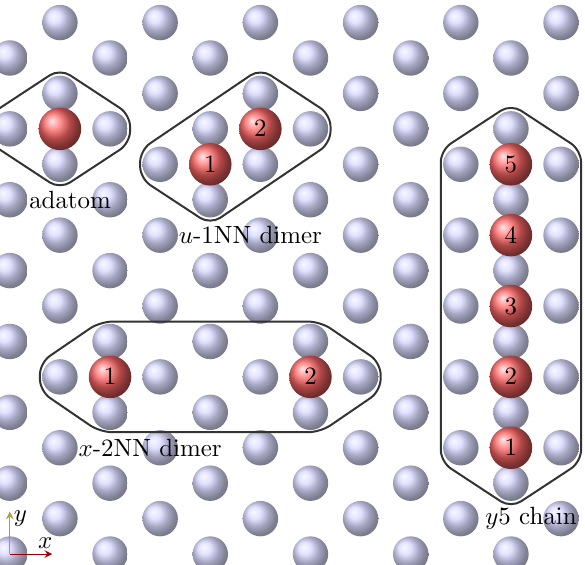
Figure 1. Illustration of the atomic clusters. Red balls represent the magnetic atoms at hollow positions on the bcc(110) surface, and gray balls represent the top Nb atoms. The clusters were calculated one by one, and contained the atoms inside the black curves. Crystallographic directions: x = [110], y = [001], u =